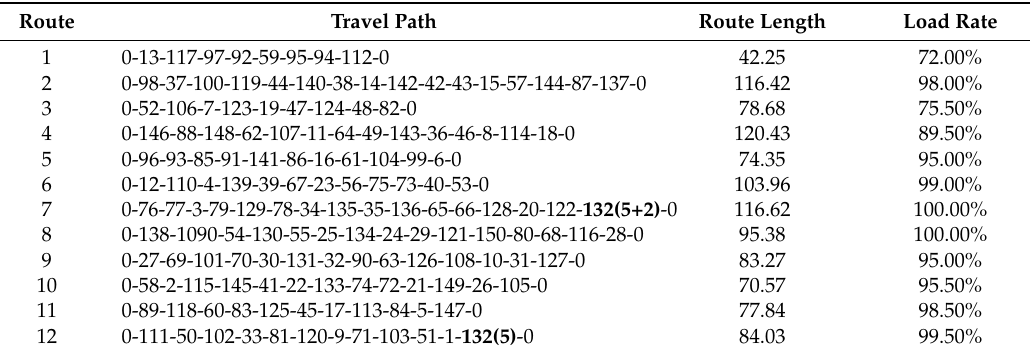
Table 3. The results of